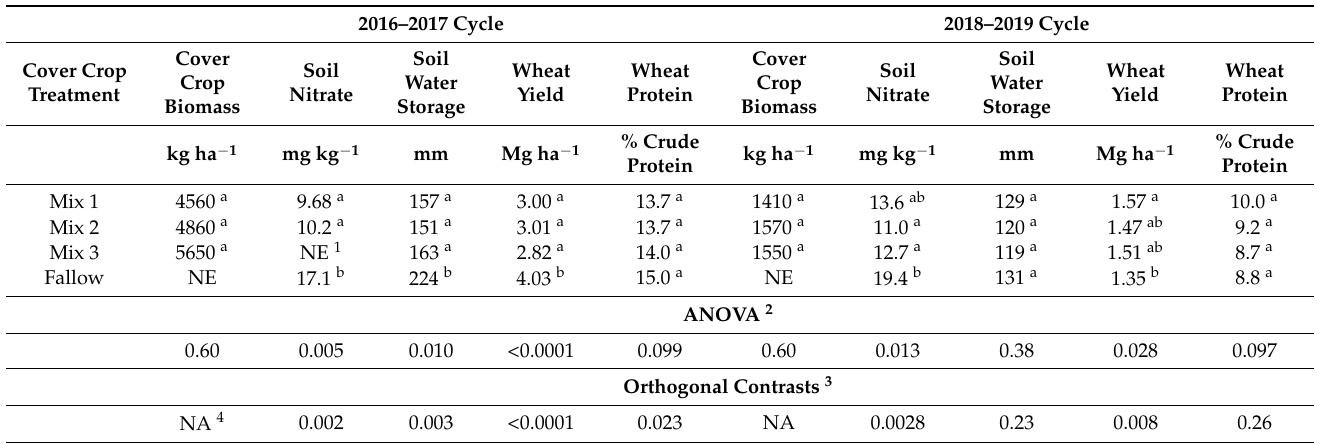
Table 4. Mean cover crop biomass, soil nitrate, wheat yield, and wheat protein values from two cropping cycles of a field trial (T1) located at the Southwestern Colorado Research Center near Yellow Jacket, CO. Values with different lowercase letters (by column) indicate differences to an alpha level of 0.05, as determined by Tukey-adjusted multiple